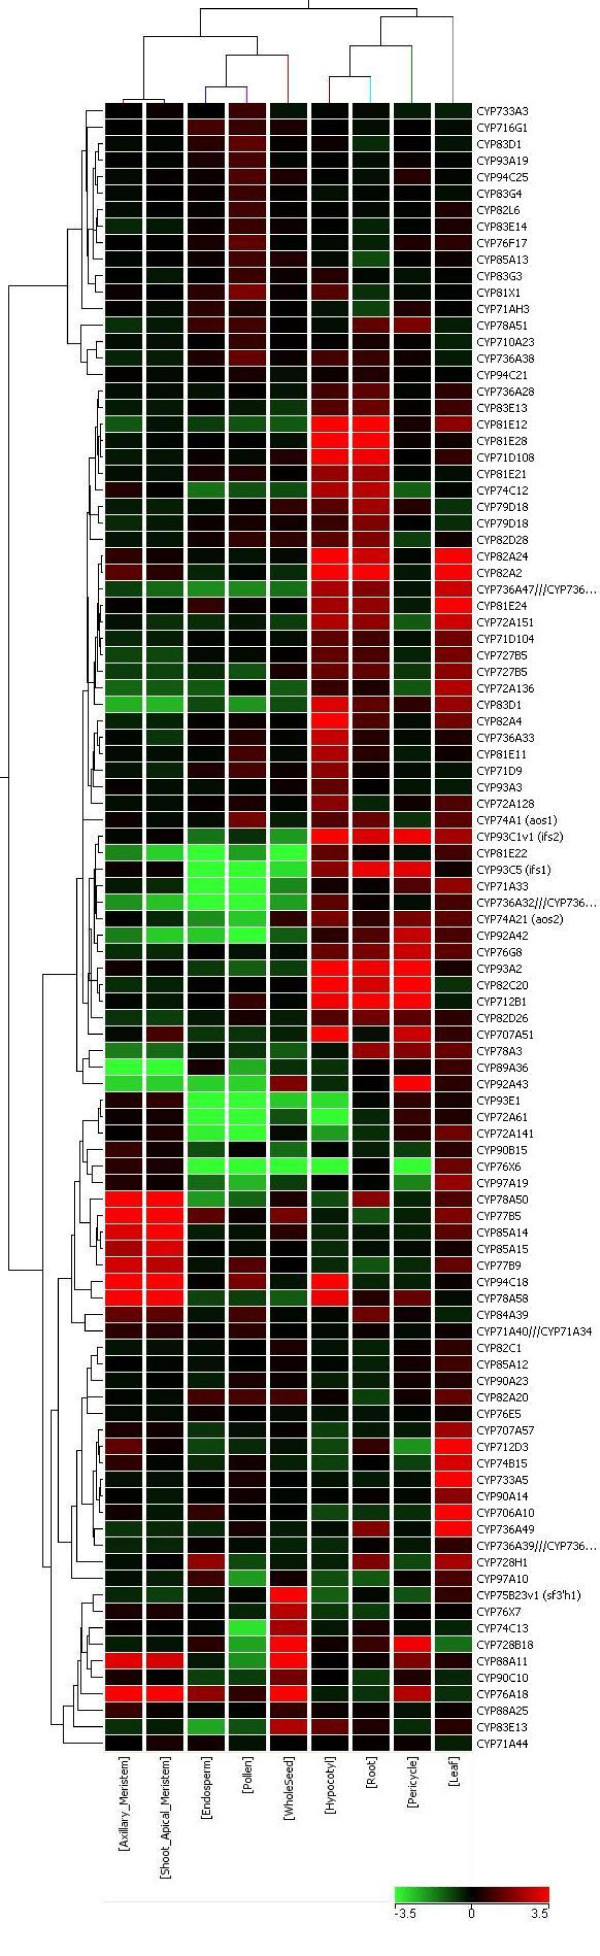
Expression pattern of soybean P450 genes in different organs according to the analysis of Affymetrix soybean microarray dataset. The color scale indicates the degree of expression (green: low expression; red: high expression). Heat map was created using GeneSpring 10X.